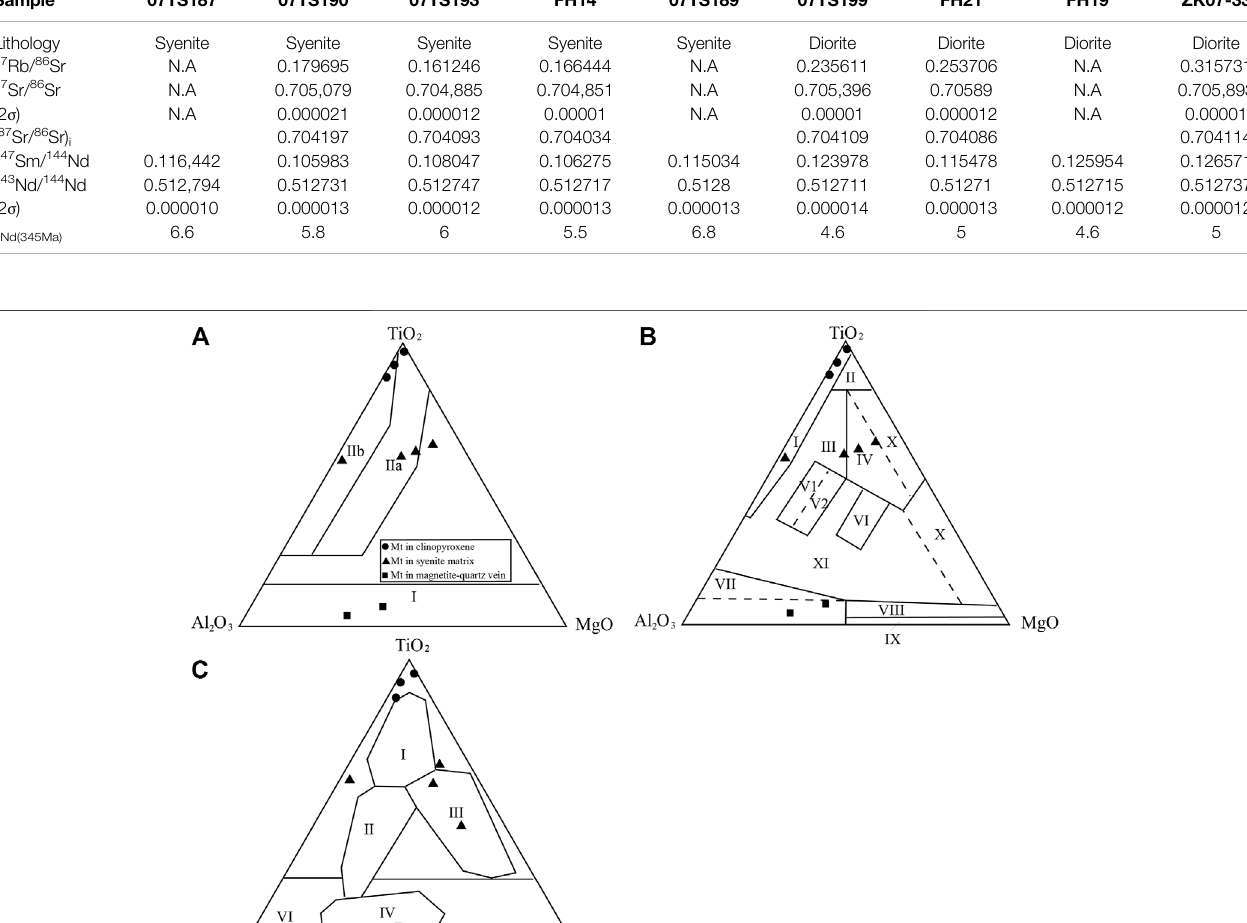
Frontiers in Earth Science |